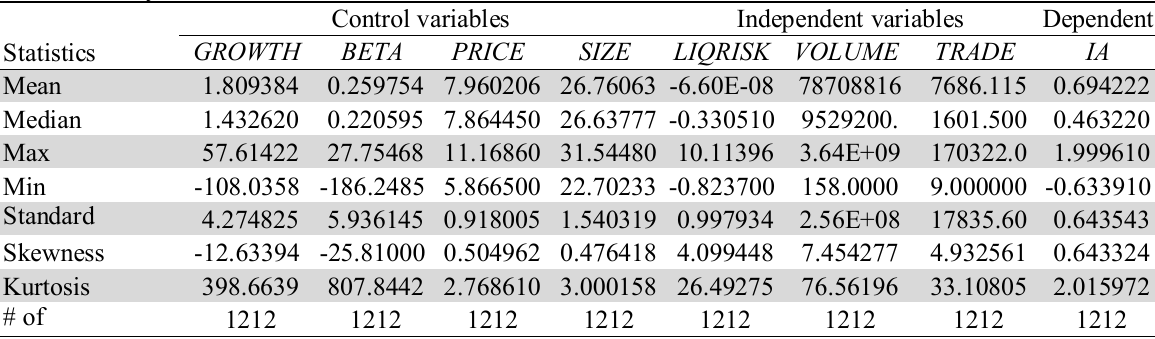
The summary of some basic statistics